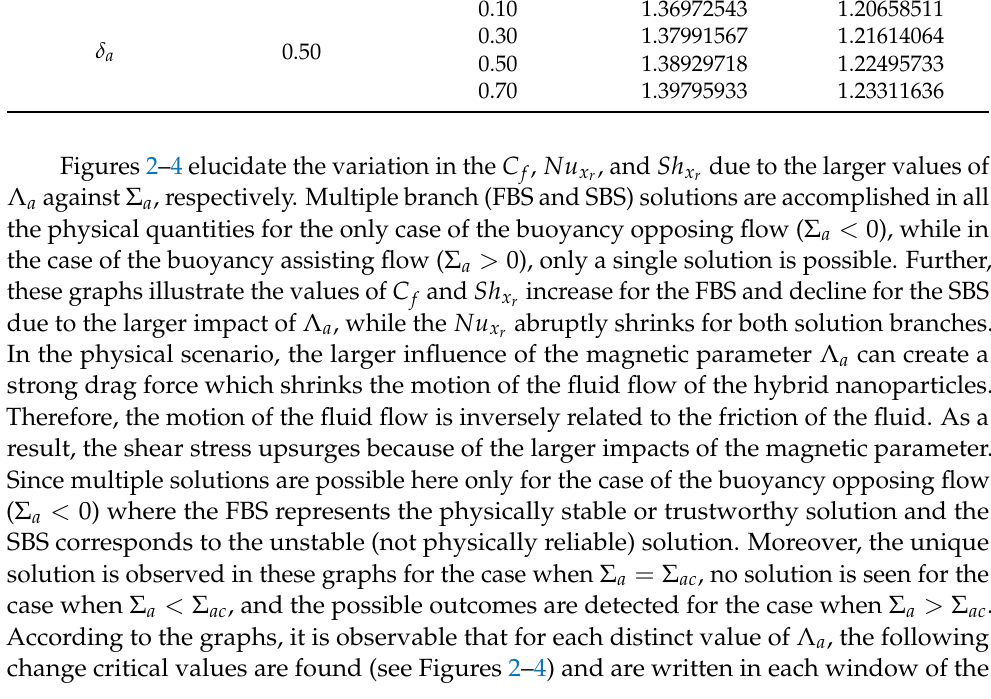
towards the variation in the pertinent flow parameters r